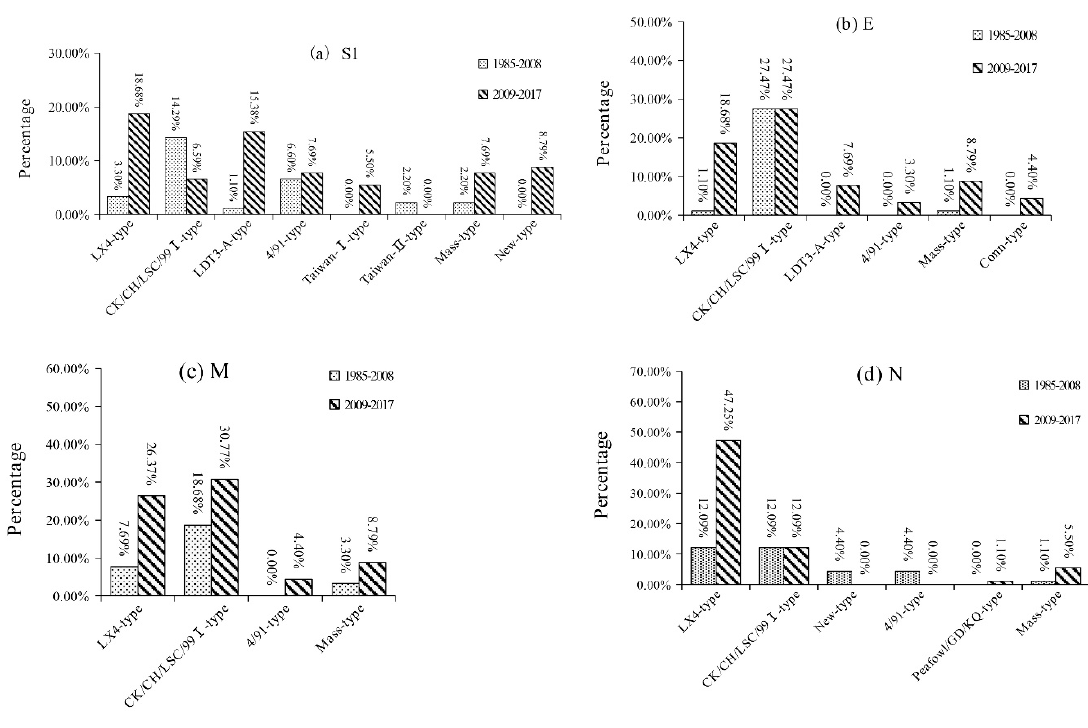
Figure 2. The percentages of different genotypes based on gene S1 ( a ), E ( b ), M ( c ), and N ( d ) of IBV strains isolated in different years.